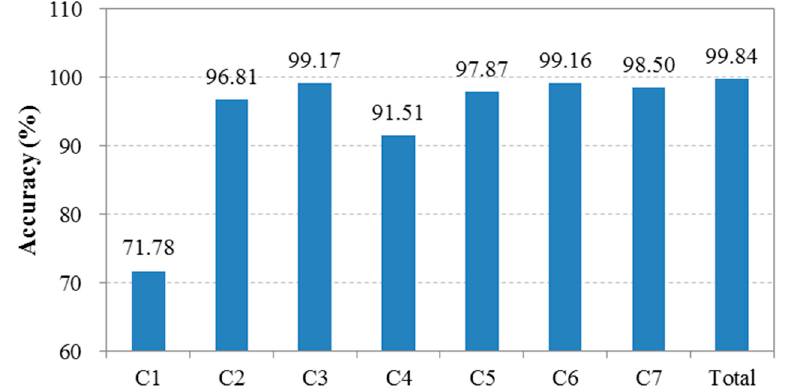
Figure 7. The detected accuracy of the tree crowns in different compartments and in the whole study area.